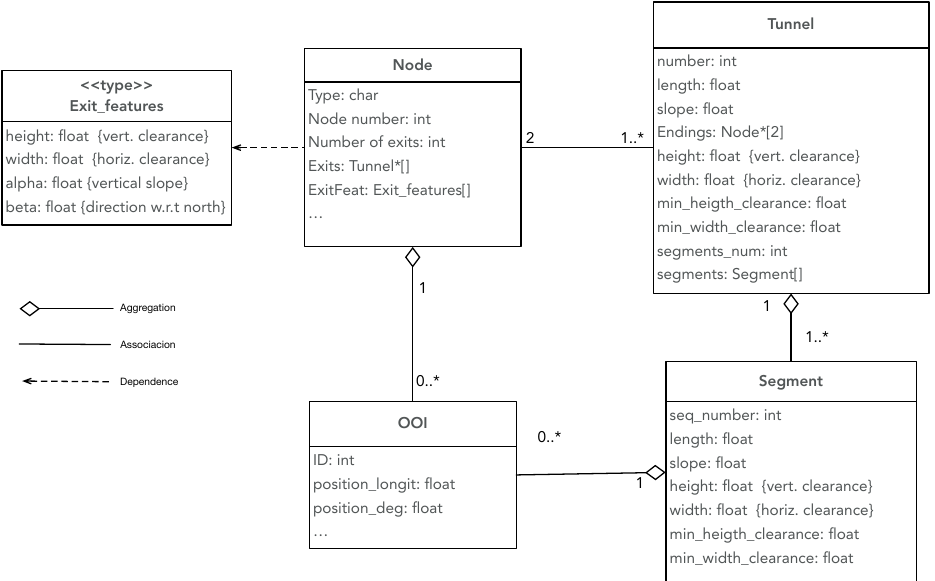
Figure 2. Diagram of the entities in the map graph. The main classes and their relationship are displayed using the UML language. Only the attributes used in this work are shown.